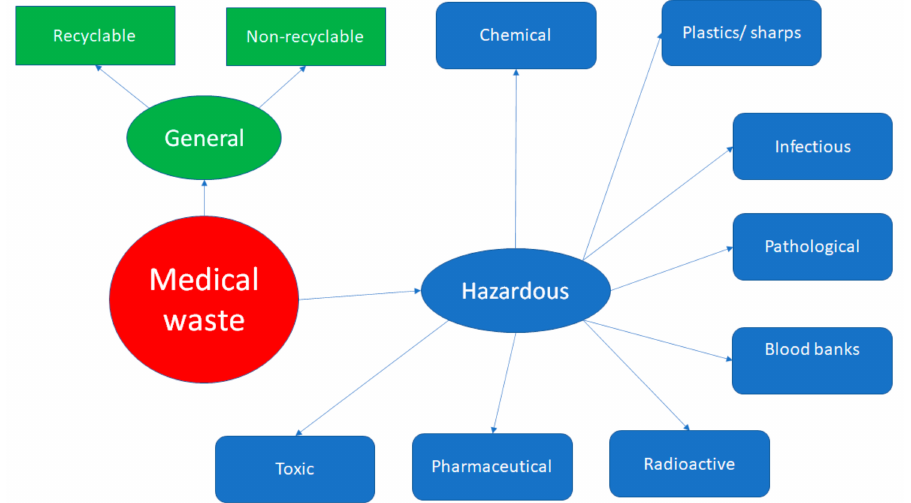
Figure 1. A schematic diagram on medical waste categories/types.